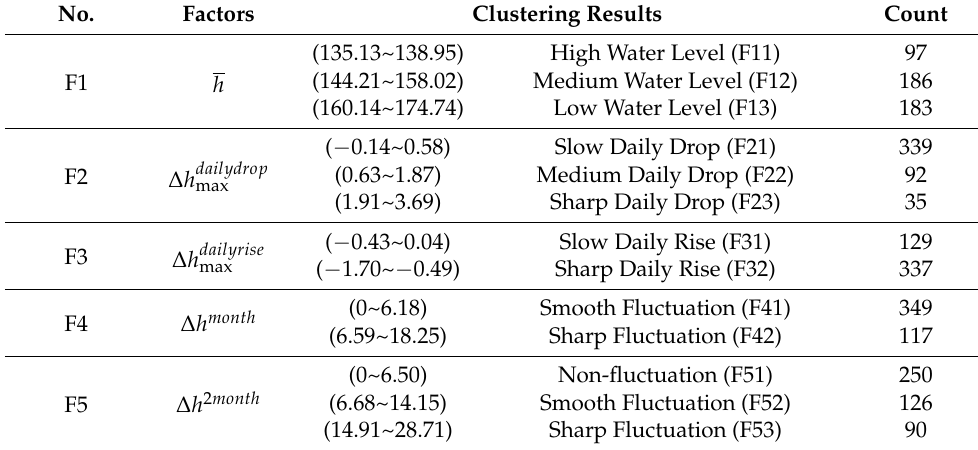
Table 2. Clustering results of the reservoir water level factors (ZG93, ZG118,